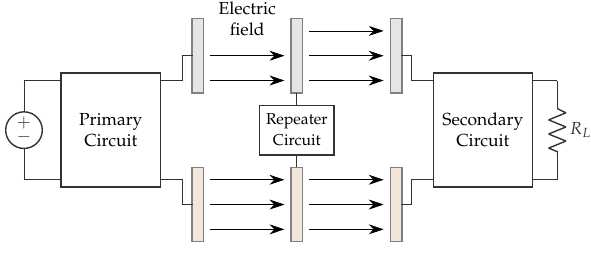
Figure 27. CPT system with one